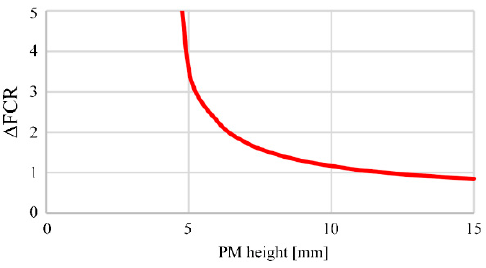
Figure 14. Relation ∆ FCR to the height of PM based on FEA [55].